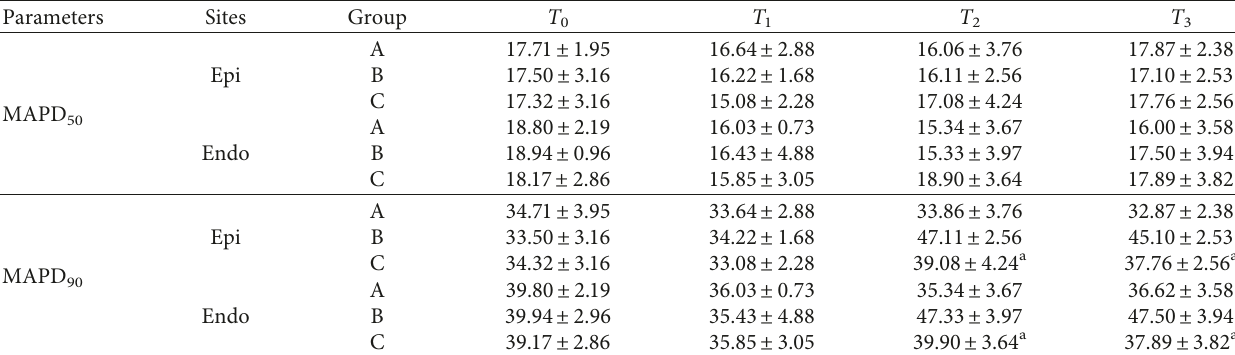
Table 2: Comparison of time for restoration of spontaneous heart beat, arrhythmia duration, and arrhythmia scores in two groups. Group N Time for restoration of heart beat ( s , x ± s ) Note: compared with group B, a P < 0 . 05. Table 3: Comparison of MAPs among three groups at different time points (ms, x ± s , n � 8). Parameters Sites